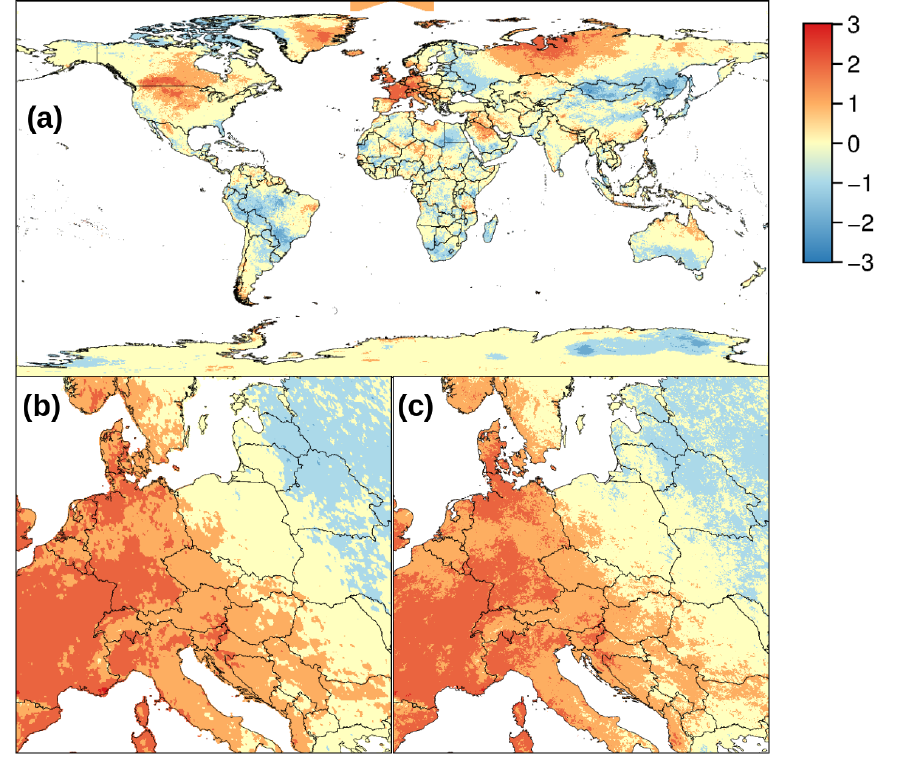
Figure 10. Intensity of the heat wave in Europe in August 2003 expressed as number of standard deviations away from the average temperature in August. Global heat wave analysis based on MOD11C1/MYD11C1 is shown in ( a ); and zoomed to Europe in ( b ). The equivalent higher resolution result based on MOD11A1/MYD11A1 is shown in ( c